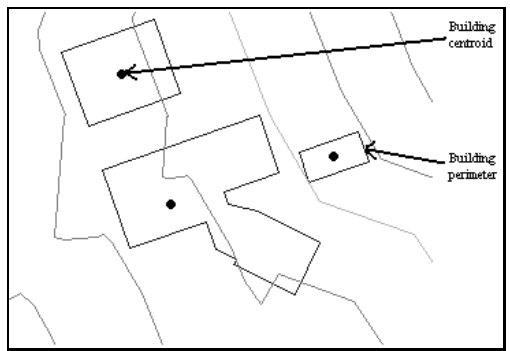
Fig 4 . A fragment of *.dwg drawing with buildings perimeters and buildings centroids